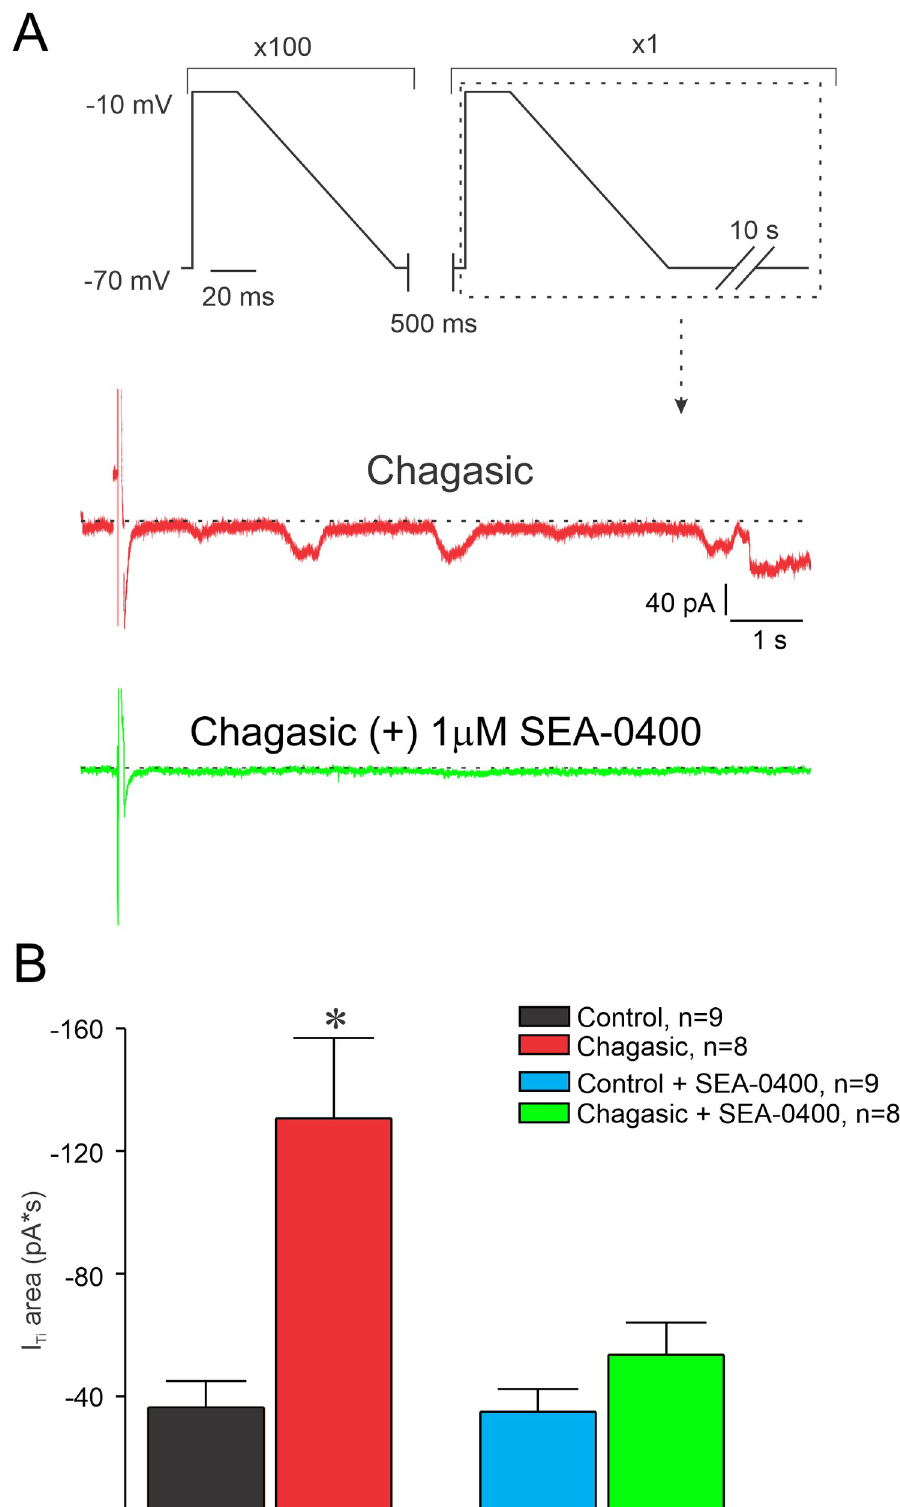
Fig 7. SEA0400 attenuates transient inward current (I Ti ) in the chronic phase of experimental Chagas disease. The protocol is depicted at the top of the figure. (A) Current traces following 100 pre-conditioning pulses and a single 500 ms pause using long pulse, before (red) and after perfusion of SEA0400 (1 μ M). (B) Composite data representing the calculated integral of the I Ti responses recorded from isolated cardiomyocytes from control and infected mice using